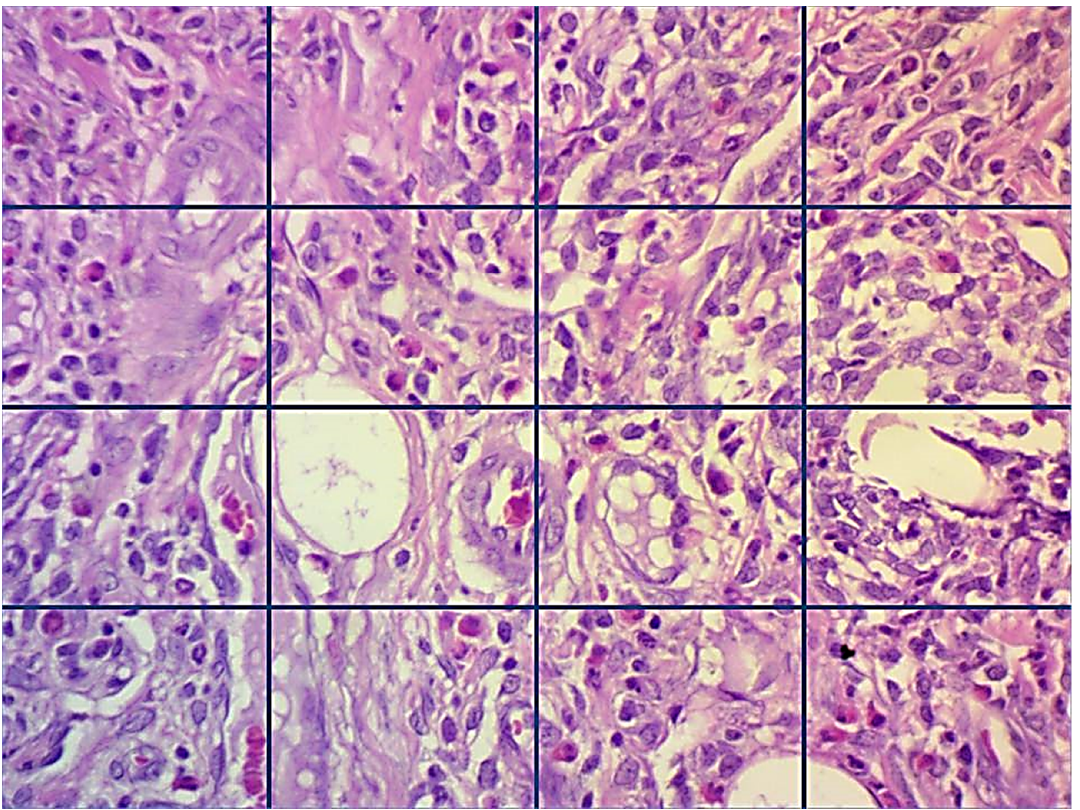
Figure 6. Scheming a method for inflammatory cells counting (H&E stains, 400×).